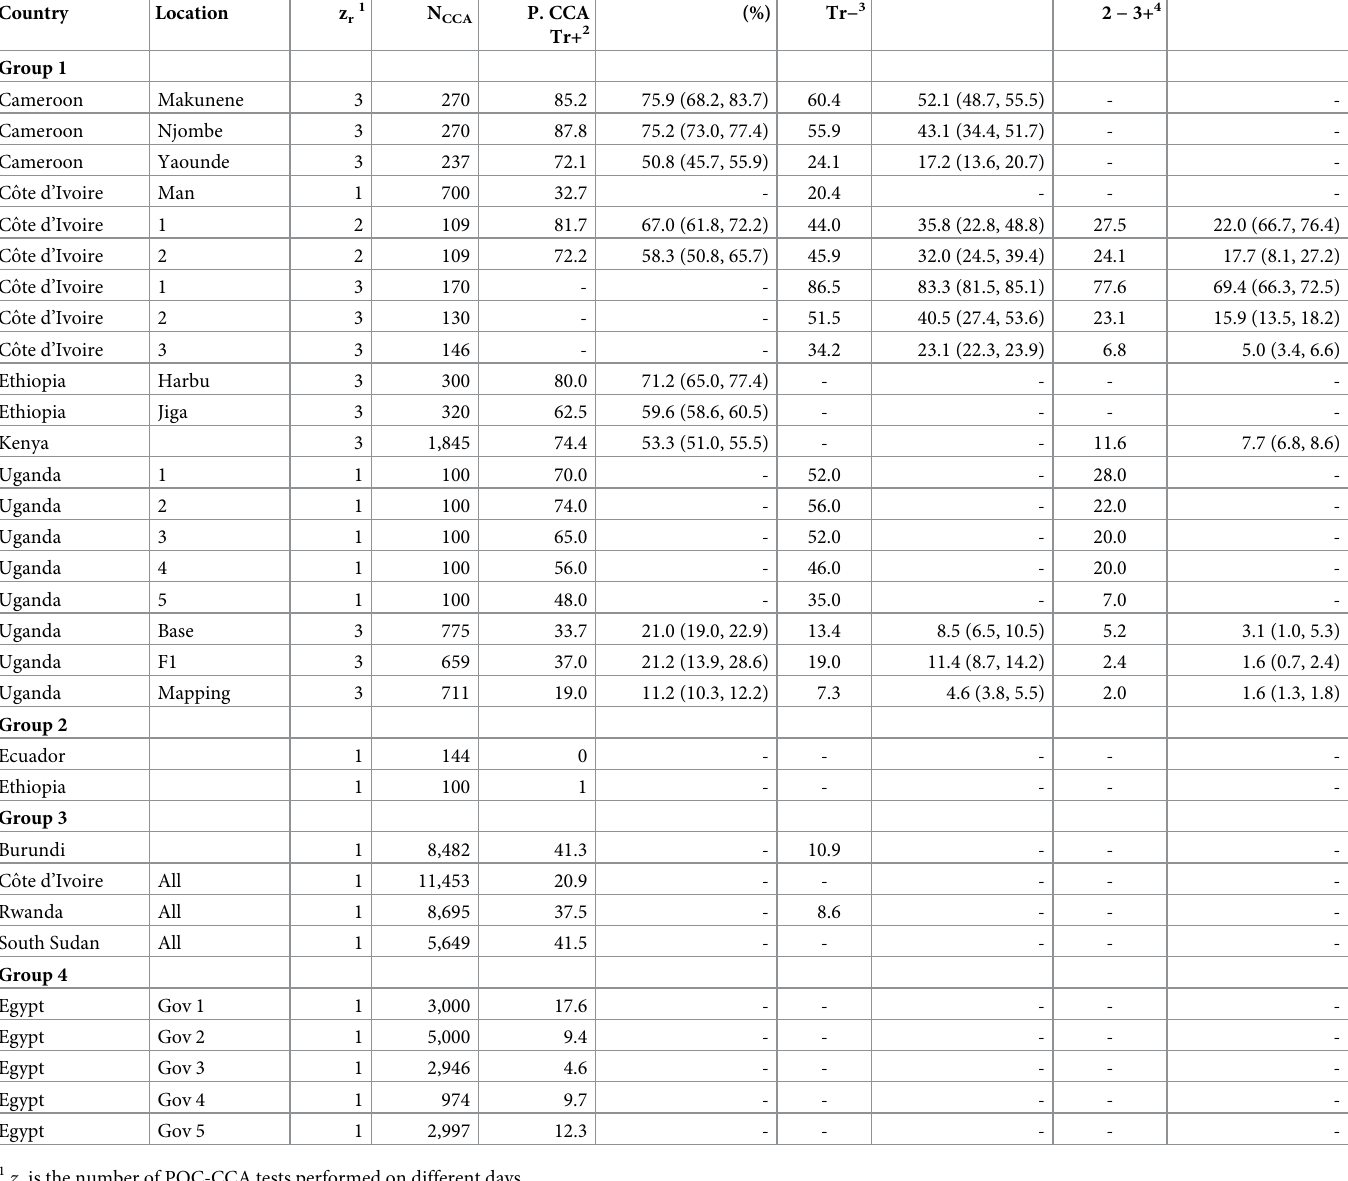
Table 2. Summary of POC-CCA results of databases employed for the current modeling study to translate Kato-Katz to POC-CCA prevalence intervention thresholds. Country